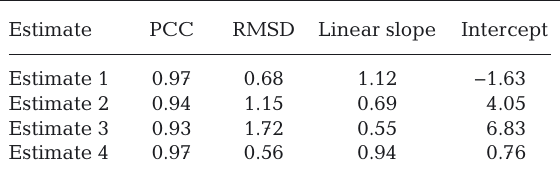
Table 3. Pearson correlation coefficient (PCC), root mean square deviation (RMSD), slope and intercept of the linear regression between 4 different ways of selecting tempera- ture in a vertical gradient and the mean temperature weighted by observed vertical salmon distribution (fish weighted average [FWA]